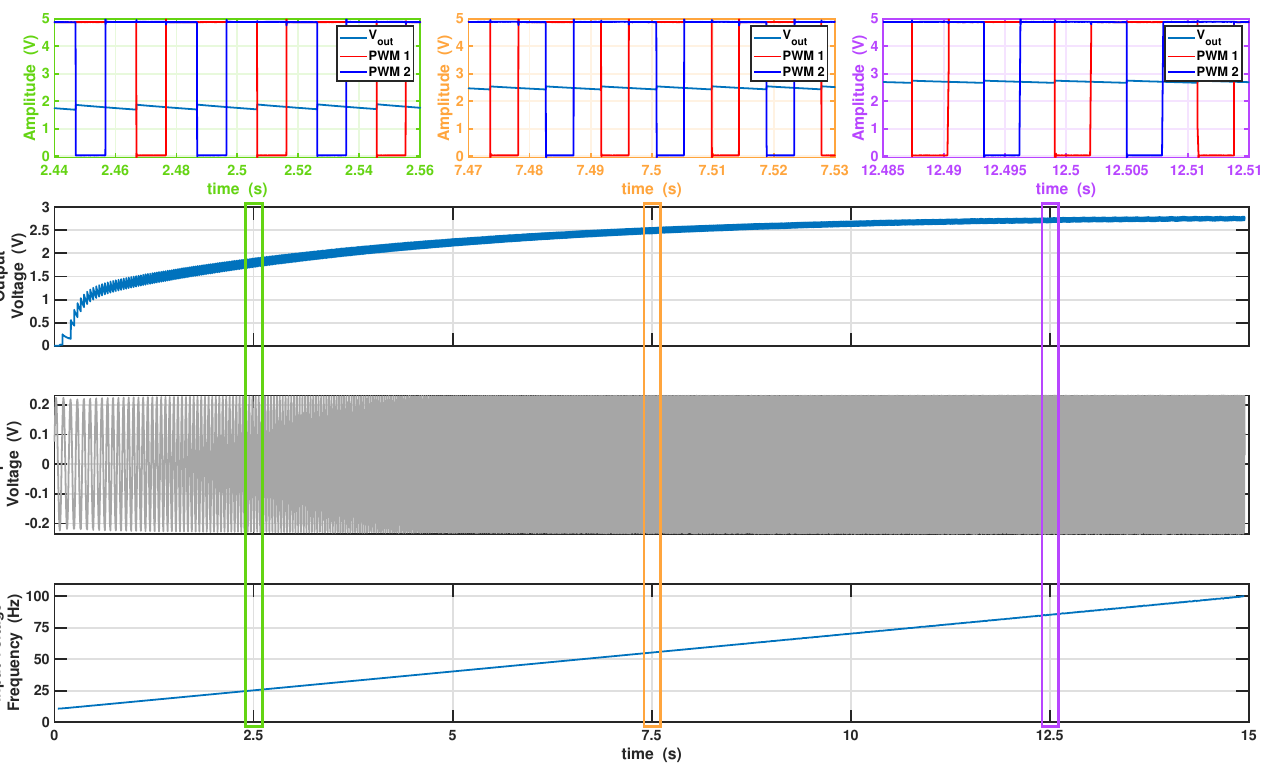
Figure 13. Measured signals of a linear swept − frequency input voltage over 15 s time interval, at D = 75% and T D = 1%. Colored boxes represent three different time spans, where the input frequency is varying around about 25 Hz ( green ), 55 ( orange ) and 85 Hz ( purple ), respectively. Top panes show the output voltage and PWM signals for each analyzed time